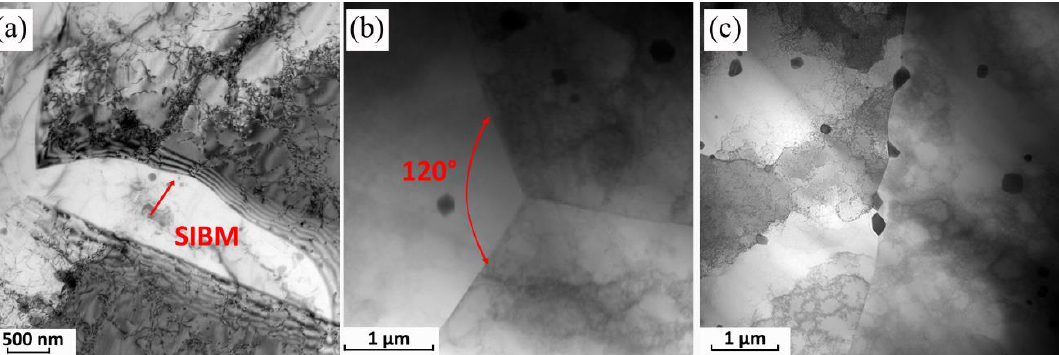
Figure 13. TEM observations of ( a , b ) SIBM and triple grain boundary in sample A; ( c ) Bright field images showing precipitates in aluminum grains and in the grain boundary of sample C.